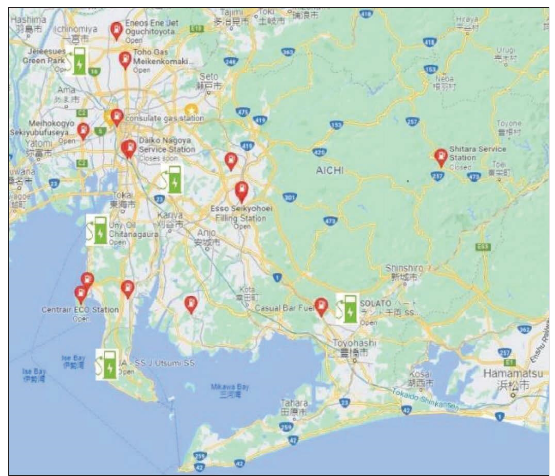
Figure 11: EVCS locations (Model M